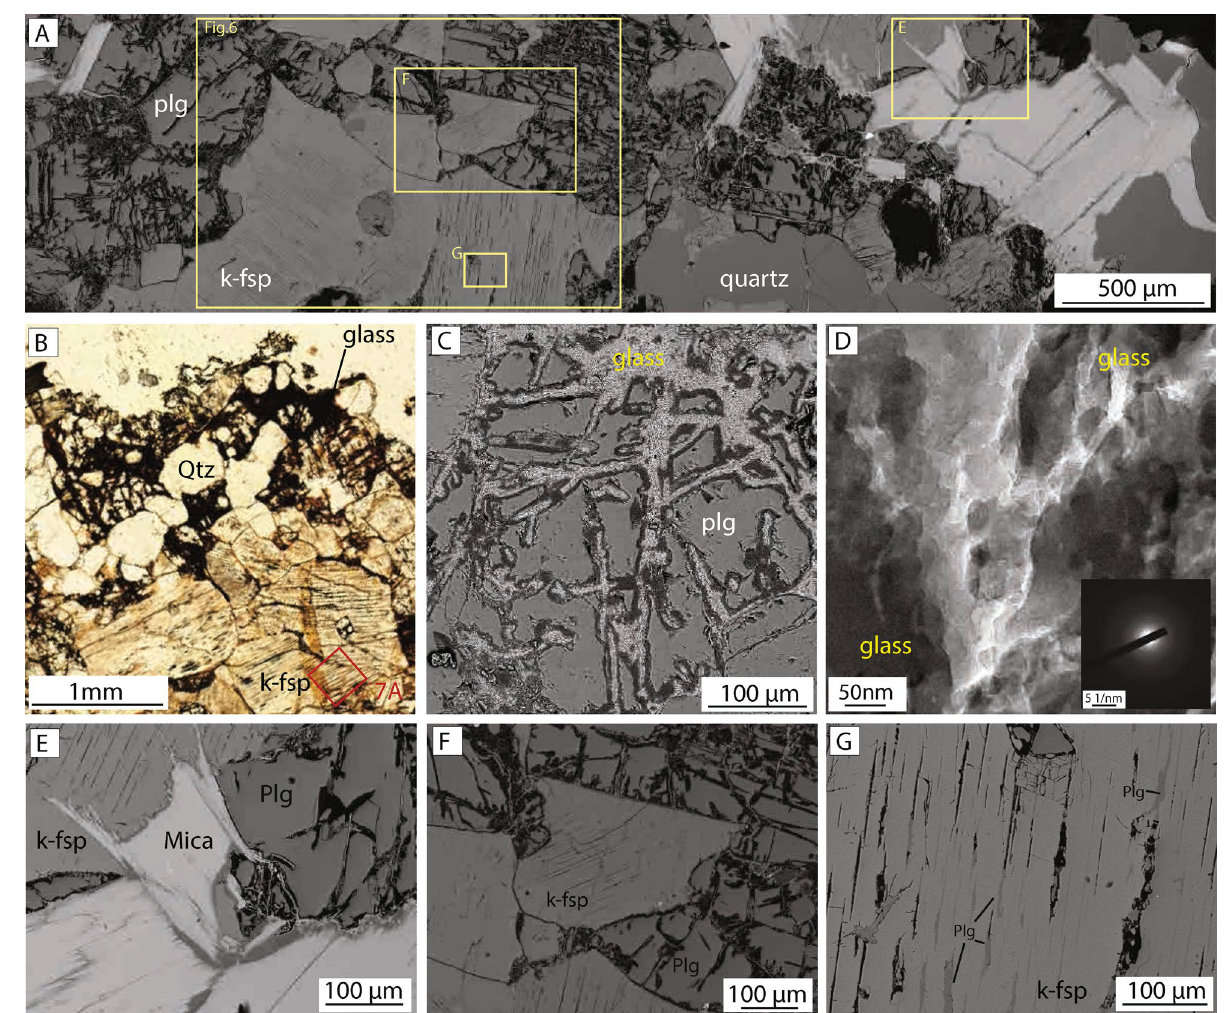
Figure 5. Microstructural characteristics of fracture-related fulgurite sample. (A) SEM backscatter image overview of the examined sample. Note the highly fractured (and altered) plagioclase where glass networks have formed, and the relative absence of glass in K-feldspar grains. (B) Optical microscope image (plane polarized light, shows the distribution of glass networks along grain boundaries. Location of in-situ synchrotron Laue diffraction analysis indicated by red box. (C) Backscatter image shows the glass network in plagioclase. (D) Transmission electron microscope brightfield image shows amorphous nature of the glassy fulgurite matrix. (E) Detailed backscatter image of the glass film surrounding the biotite and crosscutting plagioclase grains. (F,G) Backscatter images of exsolution lamellae formed in the k-feldspar host grains. Note the homogeneous nature and absence of internal structures in the plagioclase grains in (F)